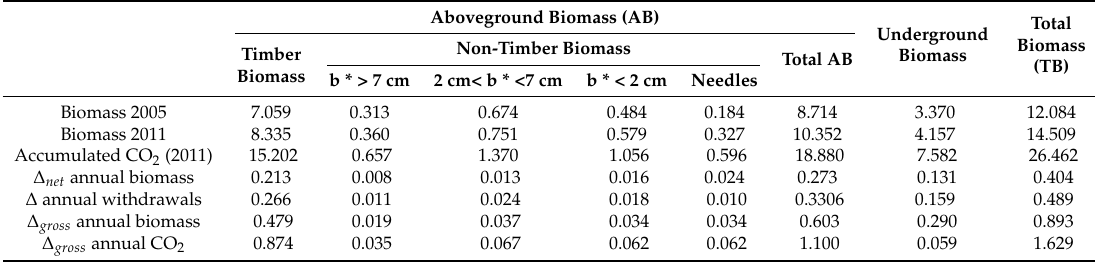
Table 3. Biomass fractions (Tg), annual increments (Tg year − 1 ), and accumulated equivalent CO 2 (Tg).